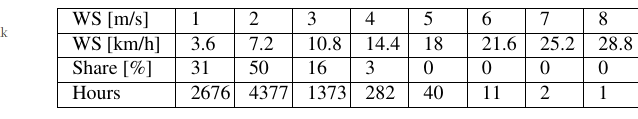
Table 2. Annual wind speed simulation results.